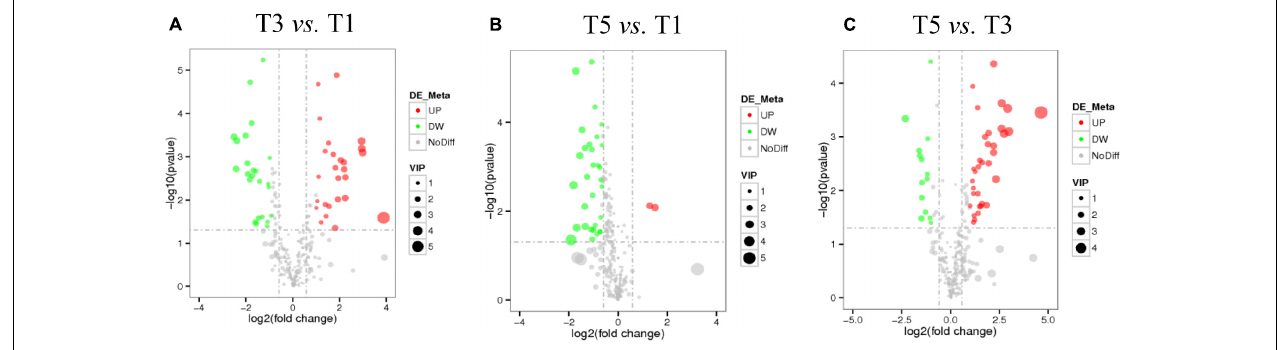
FIGURE 3 | Volcano plots show the important discriminatory metabolites between T3 and T1 (A) , between T5 and T1 (B) , and between T3 and T5 (C) , respectively.